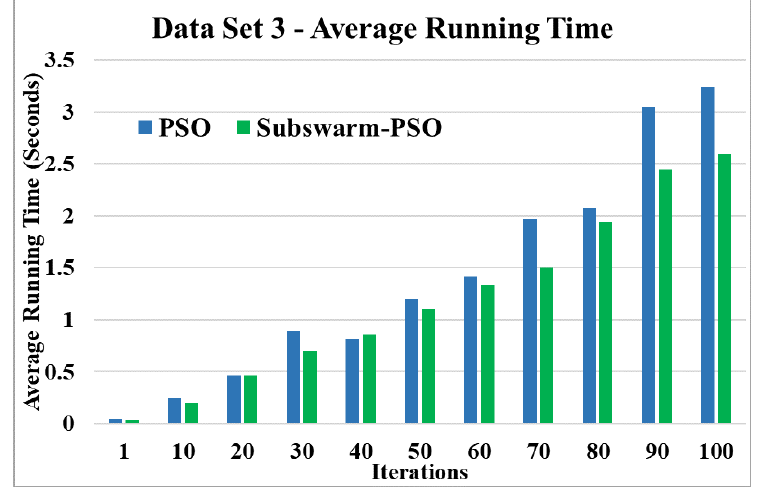
Figure 10. Average running time for data set 3.